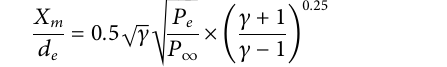
Figure 2 . An expansion fan generates at the nozzle lip as the fl ow expands into the atmosphere. The pressure ratio P 0 / P ∞ is an important parameter to describe the expansion level, where P 0 is a stagnation pressure in the vessel and P ∞ is the ambient pressure.